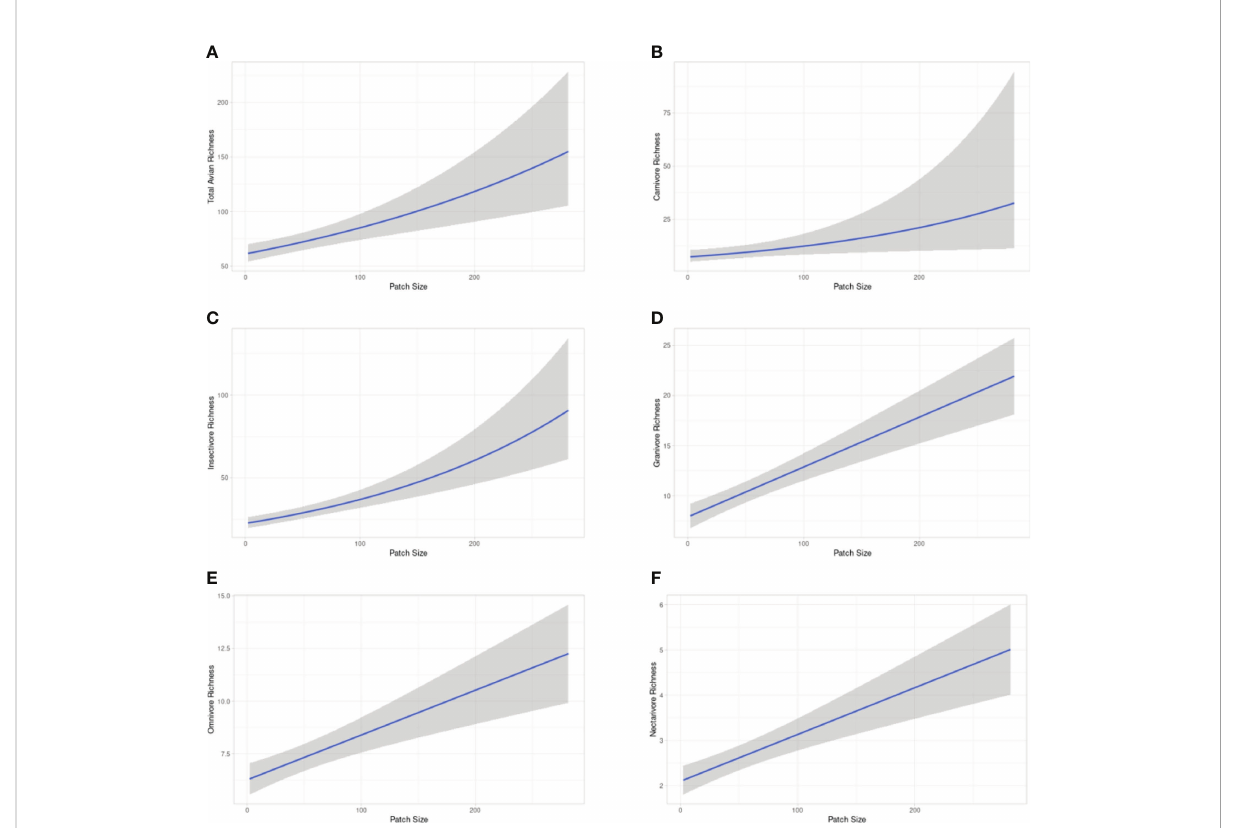
FIGURE 3 Relationship between an increase in patch size and avian richness outcomes. (A) total avian richness, (B) carnivores, (C) insectivores, (D) granivores, (E) omnivores, (F)